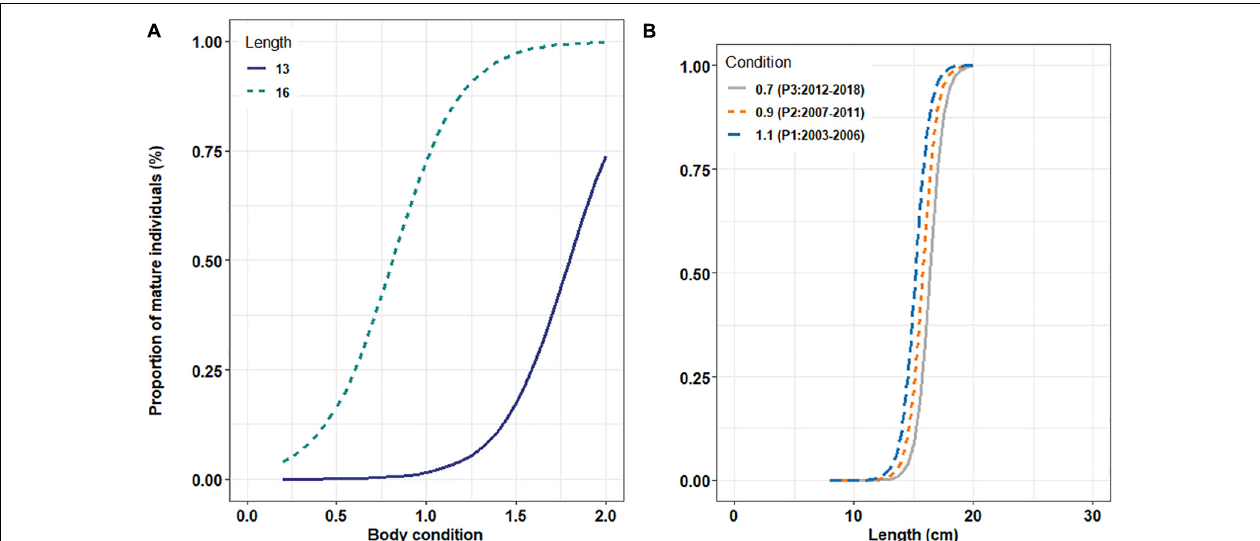
FIGURE 2 | (A) Predicted proportion of mature individuals using parameter estimates from the model (2) in springtime for two length classes (13 and 16 cm corresponding to the mean length-at-age 0 and 1, respectively) and across the observed range of body condition. (B) Estimated proportion of sardine mature at length for three levels of body condition corresponding to the median condition observed during the three periods considered (0.7 for P3; 0.9 for P2 and 1.1 for P1). Results are presented for the 2008 cohort in springtime.